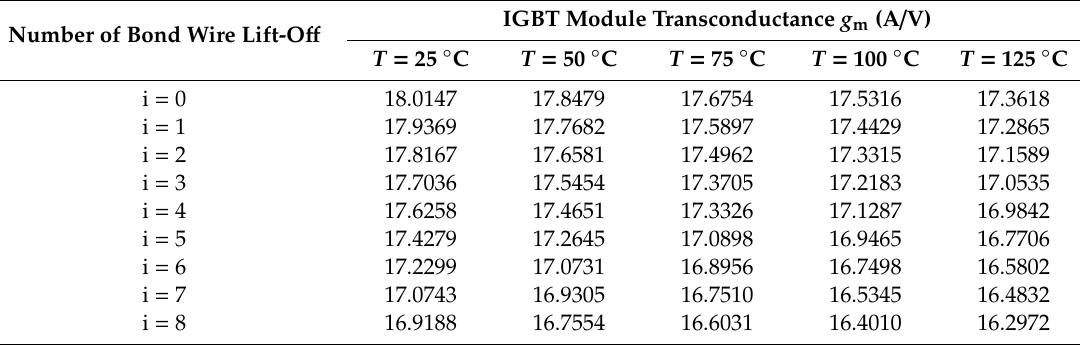
Table 9. Module transconductance of Chip 2 with bond wire failure at di ff erent temperatures. Number of Bond Wire Lift-O